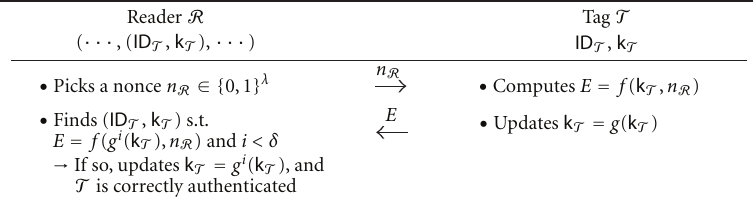
F 3: OSK-based authentication protocol.